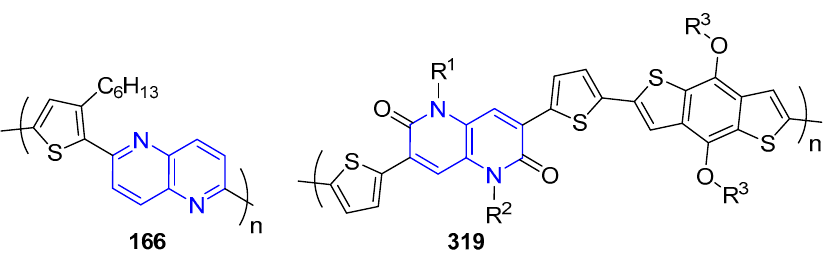
Figure 42. Semi-conducting polymers.